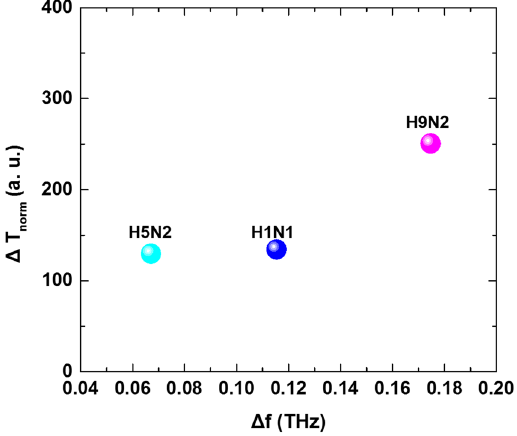
Figure 4. Classified map for various virus samples as functions of the frequency shift and transmittance decrement per unit mass. The three different subtype virus show their own frequency shift and mass- normalized transmittance